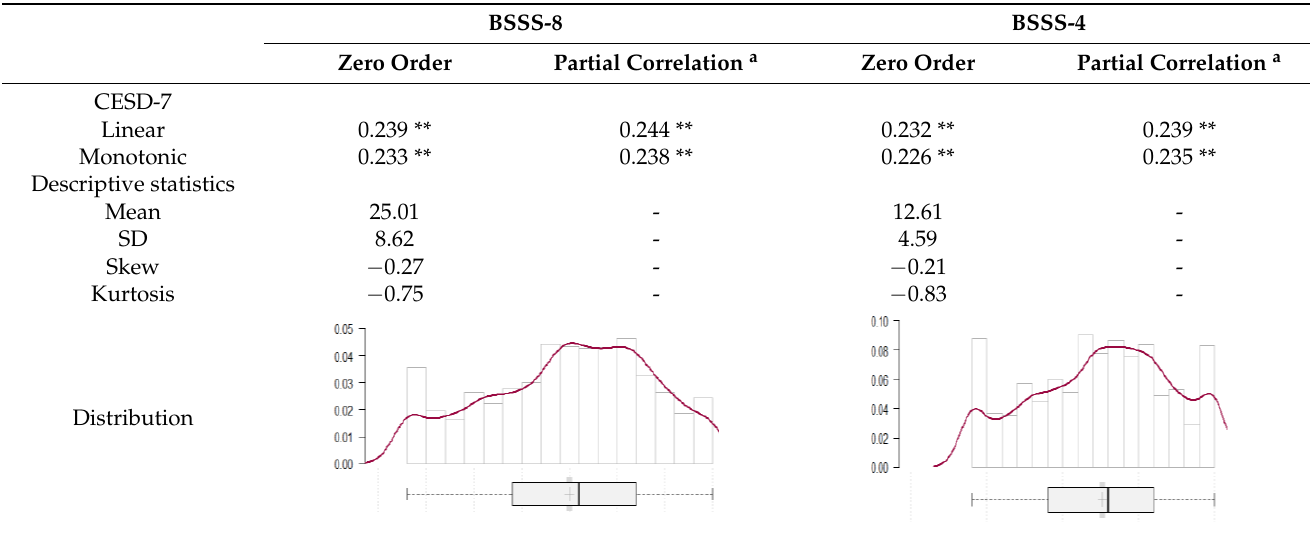
Table 5. Monotonic and linear association between BSSS scores and depressive symptoms.